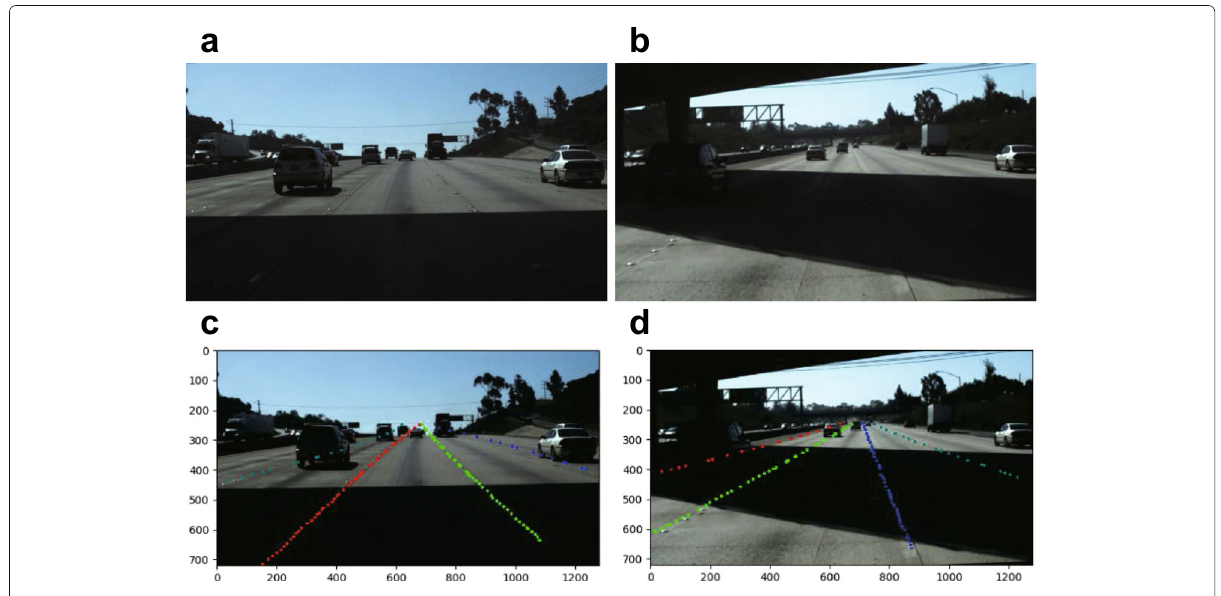
Fig. 5 Detection of lane lines under shadows and obstacles